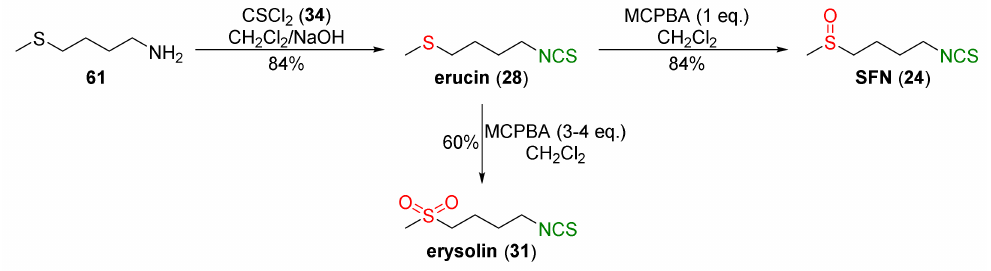
Figure 16. Synthesis of erucin ( 28 ), SFN ( 24 ), and erysolin ( 31 ). The cytotoxicity of erucin, SFN and erysolin, as well as other synthesized ITCs, were examined on eight human cancer cell lines representing a broad range of carcinomas, including breast, colon, CNS, livery, ovary, prostate, and a mouse mammary normal epithelial cell (NmuMG) control line (Table 1). Table 1. Cytotoxicity of SFN ( 24 ), erucin ( 28 ), and erysolin ( 31 ). Compound